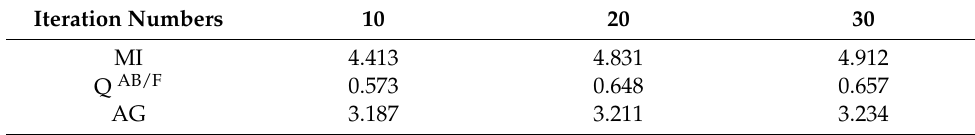
Table 6. Objective evaluation of indicators for the proposed method of different